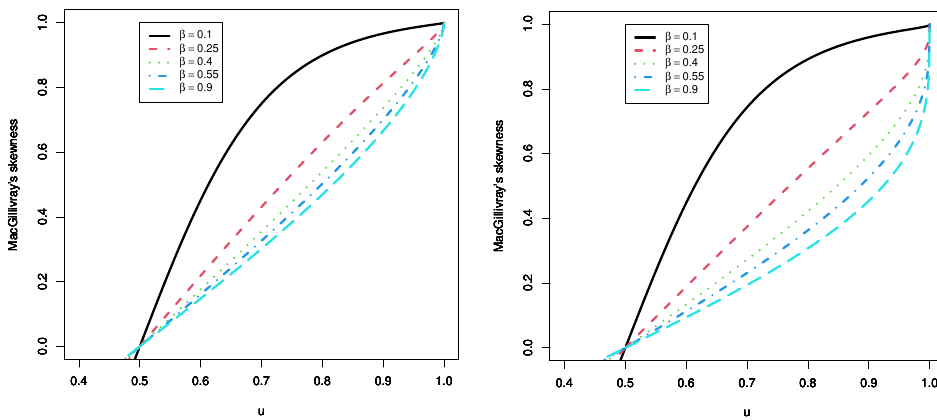
Figure 4. Plots of the MSK for the TCP-ITL distribution at a = 1.5 and